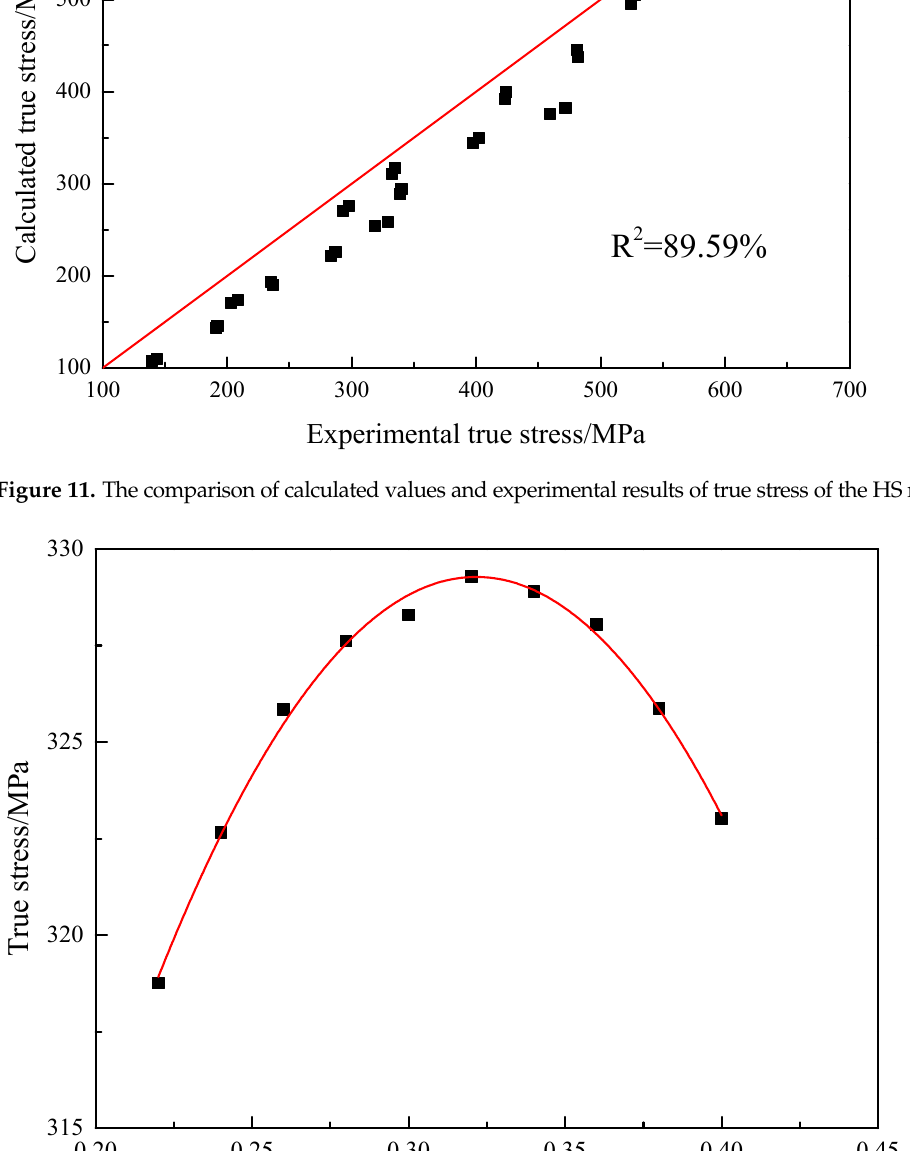
Figure 12. The true stress − true strain curve in reference temperature and strain rate.